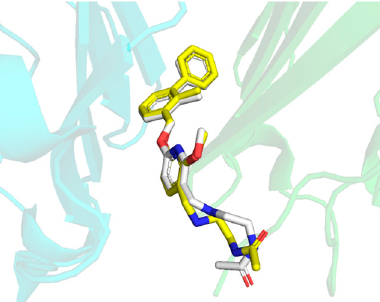
Figure 3. Superposition between the BMS-202 vina-docked conformation (yellow) and its native crystal conformation (white). Two chains in the PD-L1 dimer are annotated as A PD-L1 and B PD-L1 and colored in green and cyan, respectively.